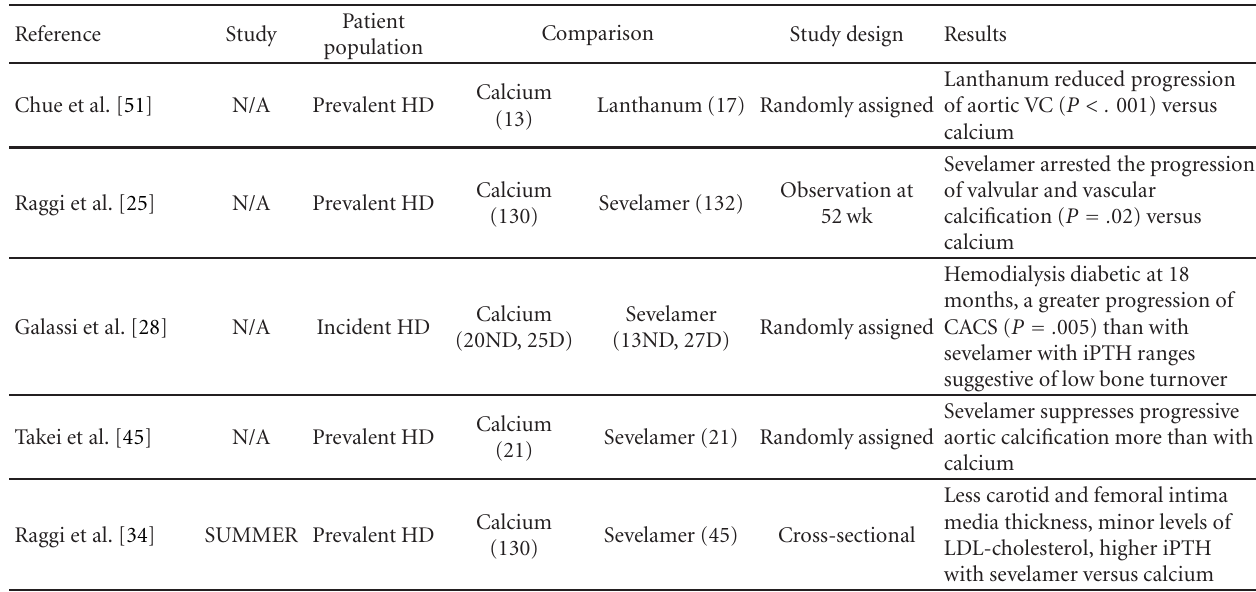
Table 2: A study analyzing the e ff ect of non-calcium-based phosphate